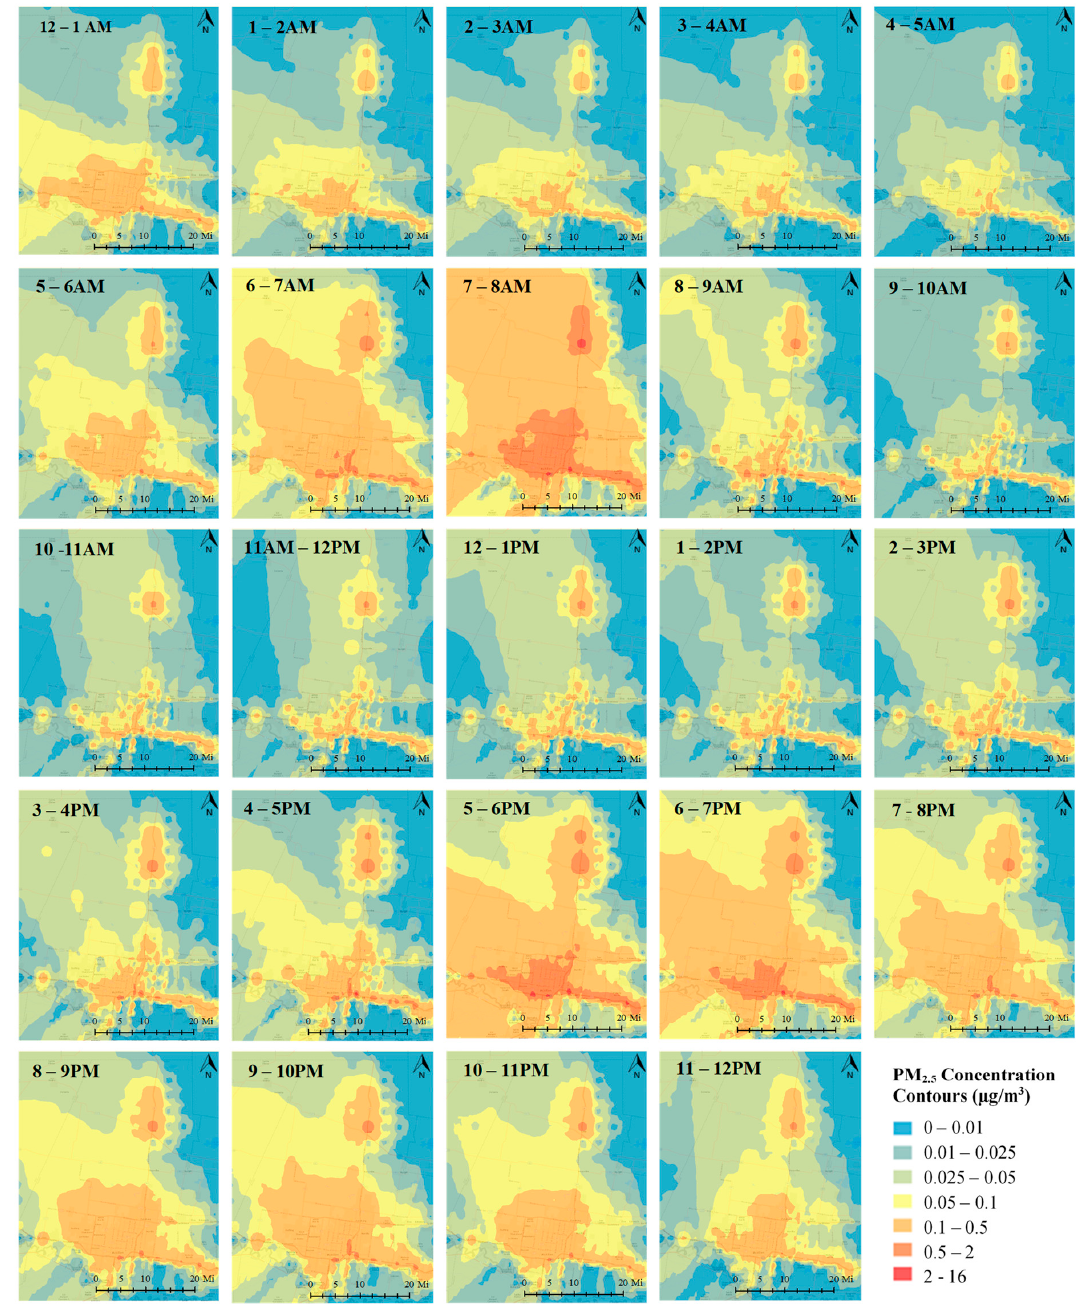
Figure 8. Spatial–temporal distribution of tra ffi c-related PM 2.5 for a sampling day on December 15, 2015.